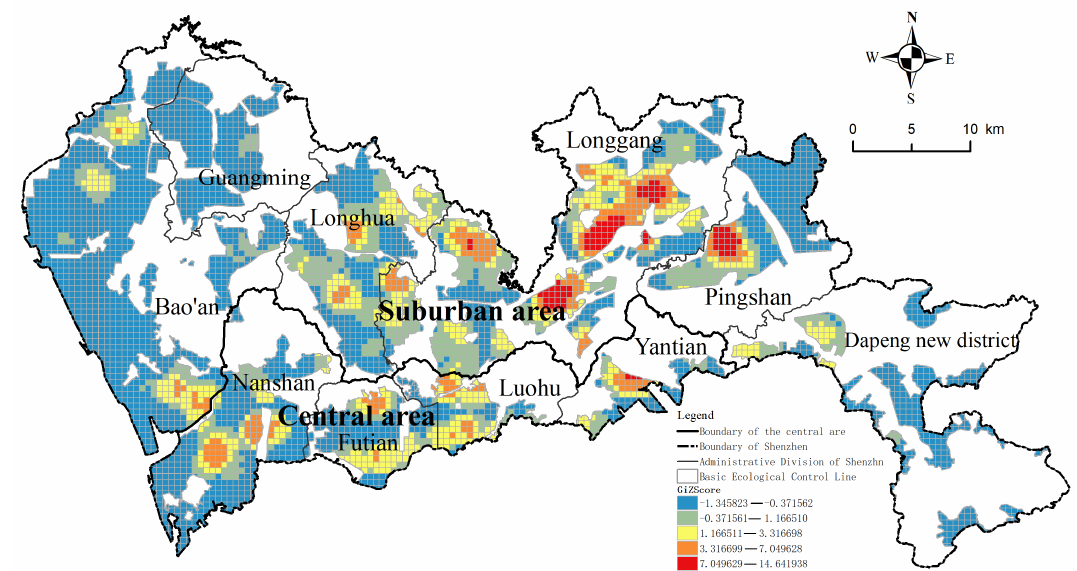
Figure 5. Getis-Ord G ∗ analysis of urban village redevelopment.